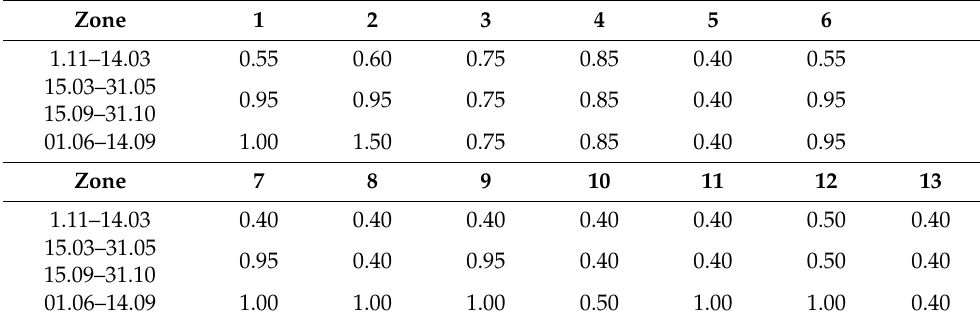
Table 4. Air change rate in the analyzed zones.